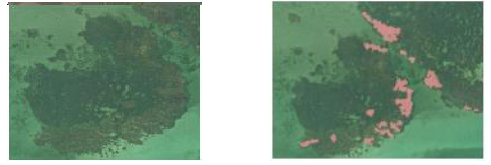
Figure 5. Possible Coral Existence with Rocks